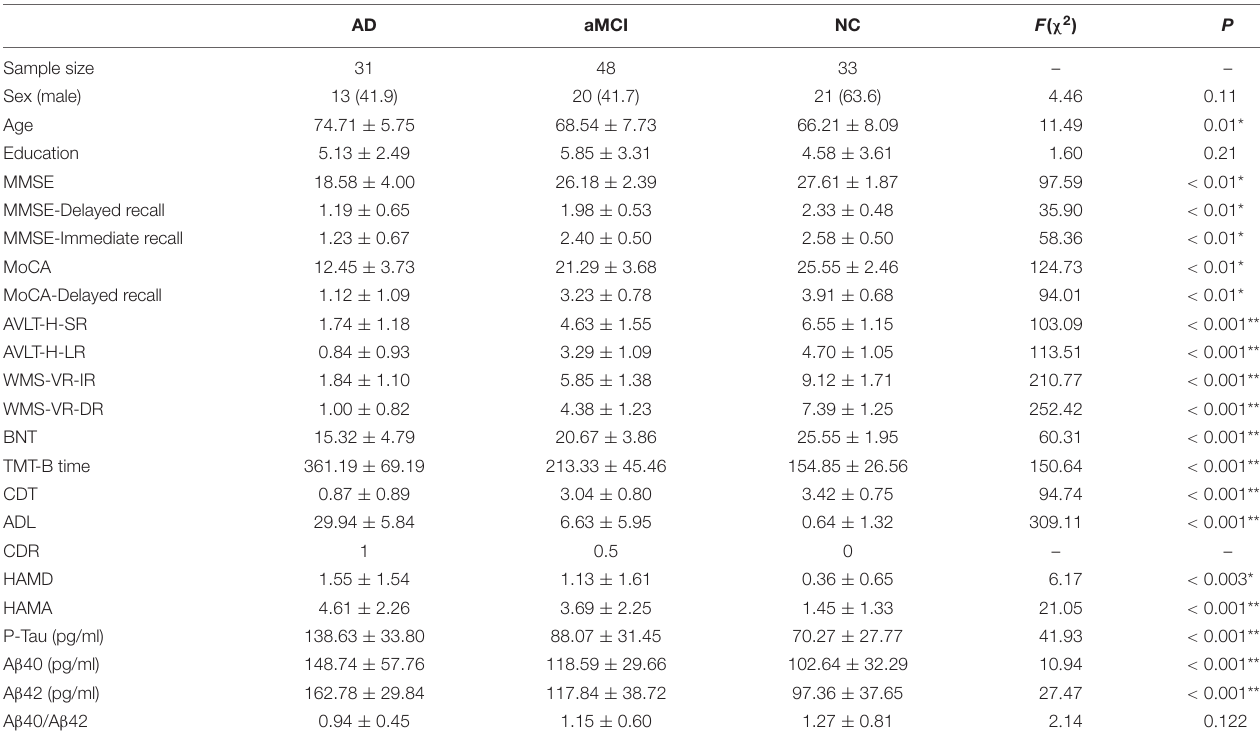
TABLE 1 | Demographic and clinical variables of